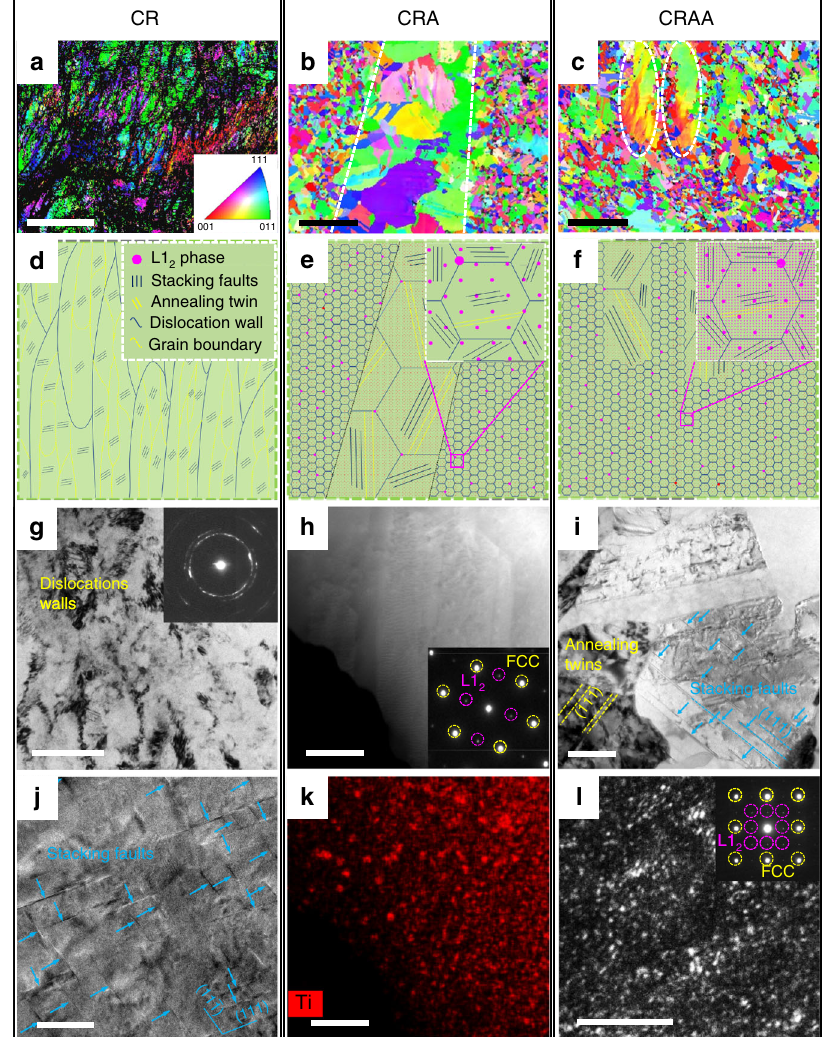
Fig. 2 The microstructures of alloys subject to the CR, CRA and CRAA processes. a , d , g , j For CR; b , e , h , k for CRA; and c , f , i , l for CRAA. a – c Normal direction EBSD inverse pole fi gure maps of alloys subject to CR, CRA, and CRAA, respectively. b , c Reveal non-uniform recrystallized microstructure resulting from the strain gradient during CR. The regions outlined by white dashed lines are coarse recrystallized grains (10 ∼ 30 μ m), whereas other regions are fi ne recrystallized grains (0.5 ∼ 2 μ m). d , e , f Schematic diagrams illustrating the microstructure evolution. Inserts of e and f are the enlarged images of fi ne recrystallized grains outlined by magenta dashed squares in e and f , respectively. g Transmission electron microscopy (TEM) bright- fi eld (BF) image and SAED pattern revealing high-density dislocation walls and large numbers of fi ne dislocation cells in the CR alloy. j High-resolution TEM (HRTEM) image of deformed grains interior showing nano-spaced SFs (blue arrows) and widely existed dislocation locks in the CR alloy. h , k High-angle annular dark- fi eld scanning transmission electron microscopy (HAADF-STEM) image and corresponding electron dispersive spectrometry (EDS) map about the Ti distribution exhibiting the Ti-rich particles; the inserted SAED patterns in h con fi rming that these particles in the CRA alloy are the L1 2 phase. i TEM-BF image of partially recrystallized microstructure showing numbers of annealing twins (yellow dashed lines) and SFs (blue arrows) exist in the CRAA alloy. l TEM dark- fi eld (DF) image and SAED pattern revealing that there are L1 2 -type particles with a high number density and an average diameter lower than 5 nm precipitating in the CRAA alloy. The scale bars in a – c , g – l are 10 μ m, 20 μ m, 20 μ m, 200 nm, 500 nm, 200 nm, 20 nm, 500 nm, and 20 nm, The combination of σ y , σ u , and ε ue indicates the current CRAA- CRA conditions show high strain-hardening rates at high stress treated MEA is apparently superior to those already reported levels. Microstructures . The electron microscopy images showing the Fig. 1. For example, the CRAA-treated alloy gives promising characteristics, about 10% higher in σ y , 15% higher in σ u , and 44% microstructures via the CR, CRA, or CRAA treatment are pre- higher in ε ue as compared with the ultra-strong HEA strength- sented in the left, middle, and right columns of Fig. 2, respec- ened by high-content coherent nanoprecipitates (the orange tively. Figure 2a – c are the electron backscatter diffraction (EBSD) region shown in Fig. 1b and Supplementary Fig. 1) 22 . The work maps showing the evolution of grain structure for three alloys hardening rate plot for the samples of annealing and aging can treated by CR, CRA, and CRAA, respectively. Figure 2d – f are the also be seen in the insert of Fig. 1a. Both the CRAA and corresponding schematic version to show the structural evolution.